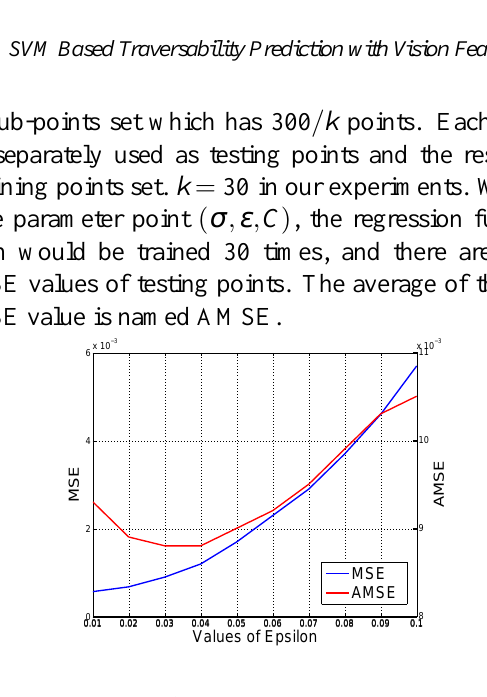
Fig. 6. The values of MSE and AMSE, s = 0 . 007 , C = 5. The curves shown in Fig. 6 present that the MSE decreases when e decreases, but the AMSE is the lowest at e = 0 . 03 , 0 . 04 and it increases back with smaller e . The AMSE is better than MSE to describe the performance of the parameter point. So the opti- mization of parameters is to minimize the AMSE in parameter space.